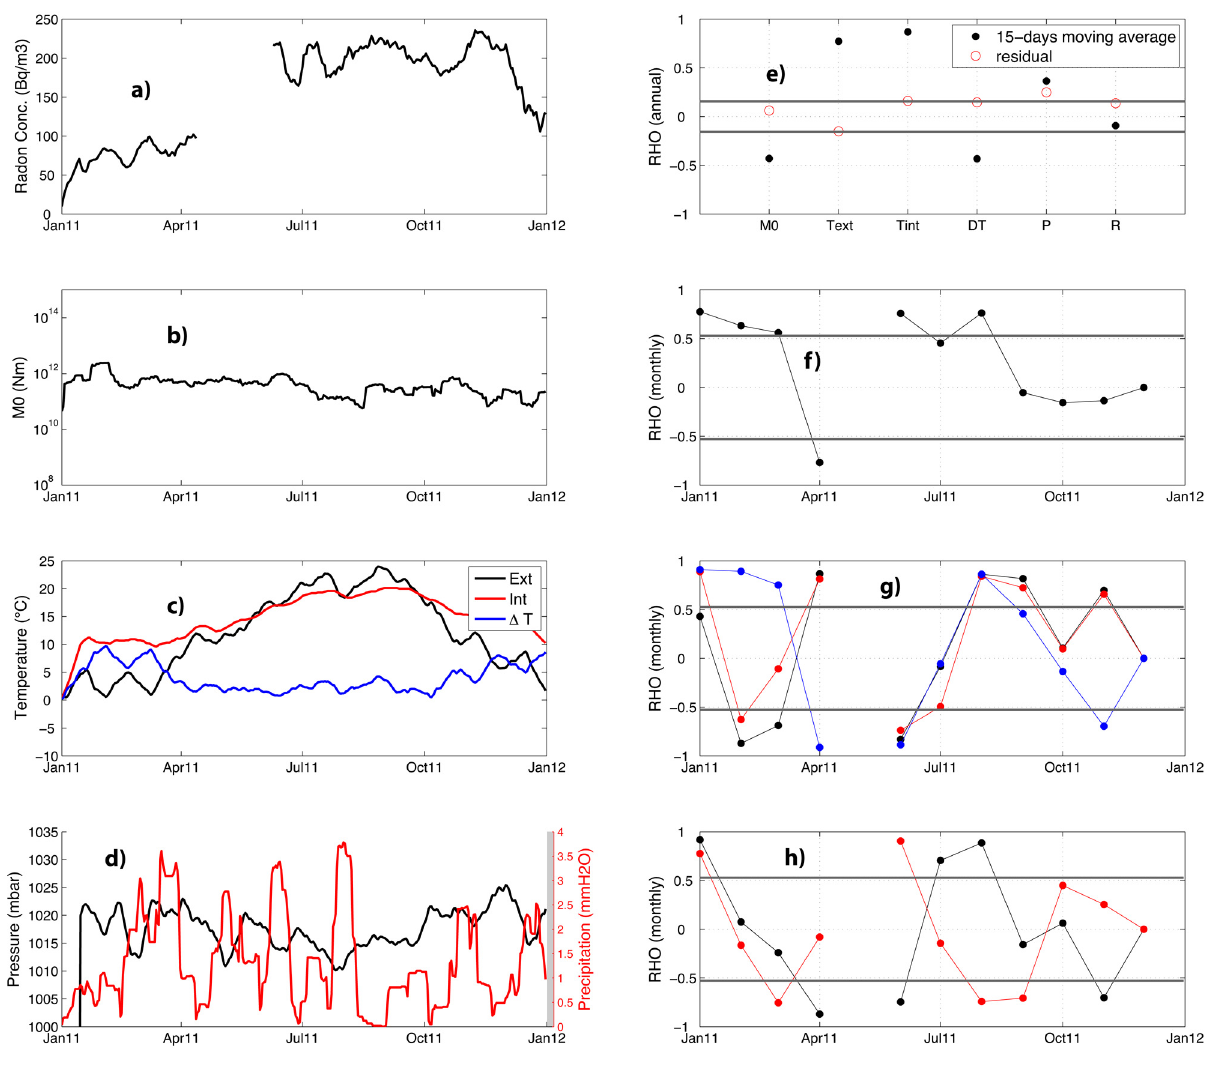
Figure 5. Left panels from up to bottom (a-d): 15-days moving averaged time series of radon concentration, cumulative seismic moment (in logarithmic scale), temperature (black external, red internal and blue their difference D T ), pressure/precipitation (black and red line, respec- tively) between January 1, 2011 and December 31, 2011. Right panels from up to bottom: (e) annual value of Pearson’s correlation coeffi- cient (RHO) between radon concentration and each one of other variables in left panels (both between 15-days moving averages and residuals obtained subtracting the 15-days moving average from the unfiltered data); (f-h) monthly trend of RHO evaluated between radon concen- tration and cumulative seismic moment/temperature/pressure/precipitation; horizontal gray lines represent 99% confidence